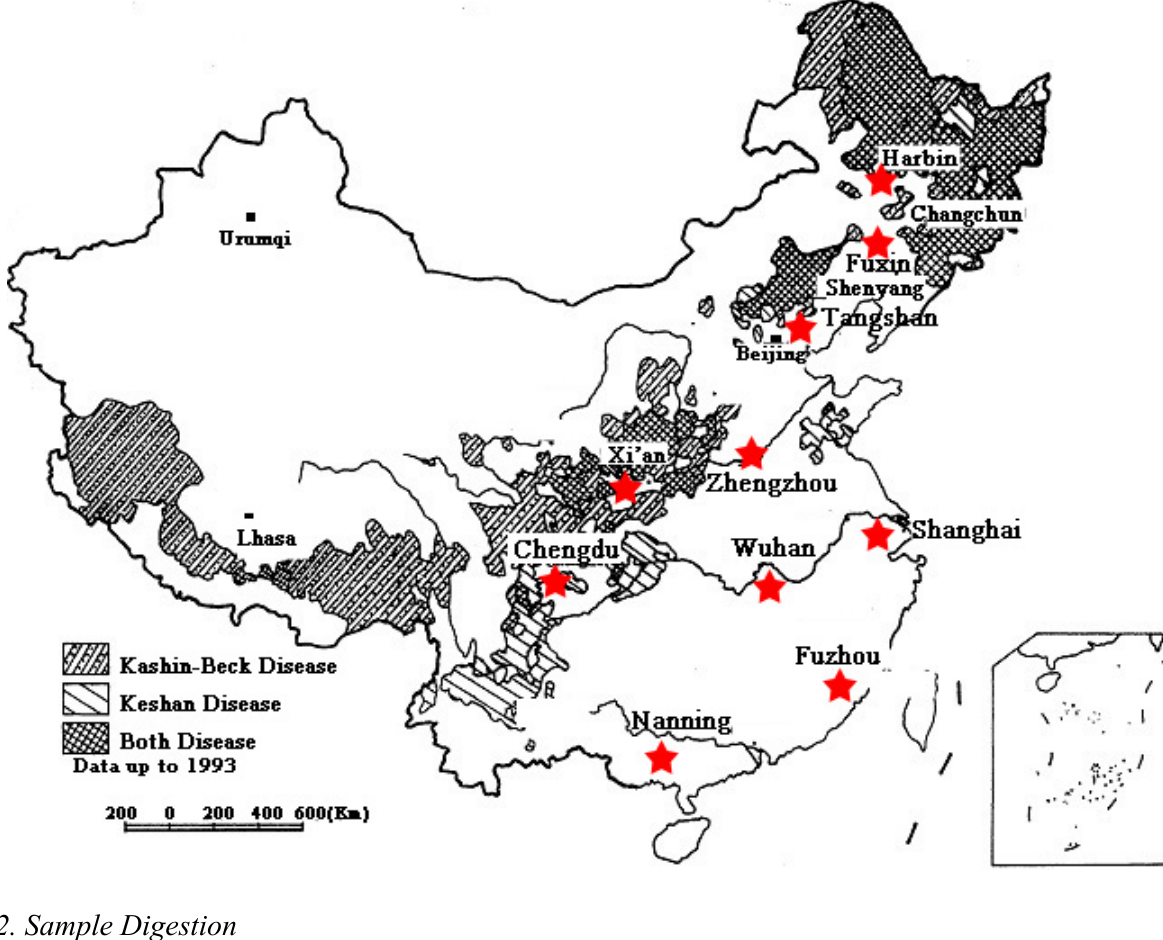
Figure 1. Distribution of KSD, KBD (by disease-affected countries) [4] in China, including the study areas within our survey (designated with red